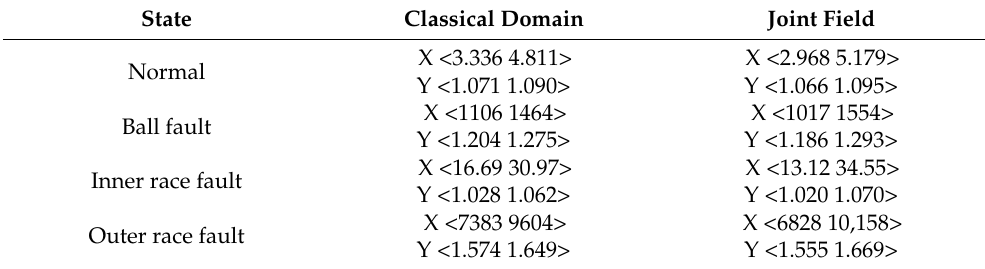
Table 5. Classical Domain and Joint Field When SPOF Diameter = 0.007 in, HP = 1.